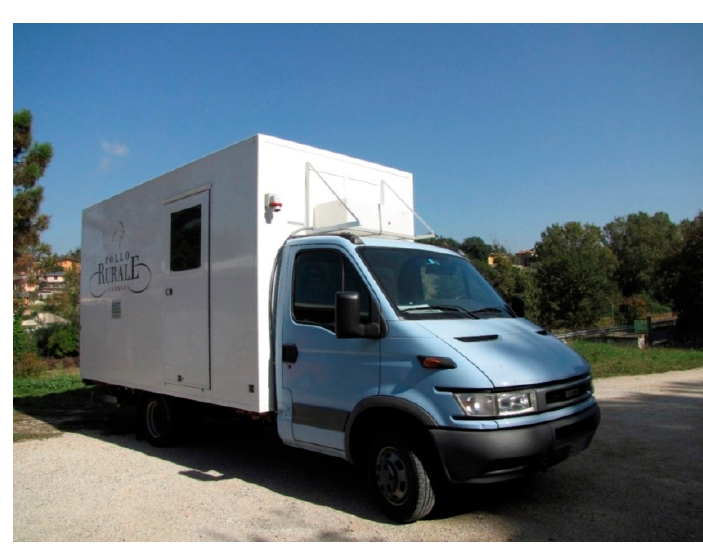
Figure 2. Photo image of a MPPU.